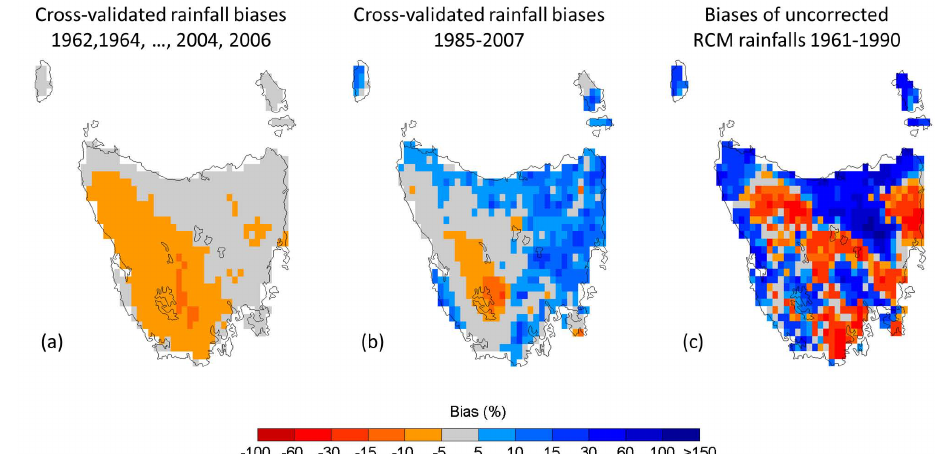
Fig. 4. Effects of changing the training period on quantile mapping performance. Plots show biases in mean annual rainfall for the 10km 2 GFDL-CM2.0 simulation. (a) Biases of bias-corrected RCM rainfall where quantile mapping is trained with the period 1962–1984; biases shown are calculated for 1985–2007. (b) Biases of bias-corrected RCM rainfall where quantile mapping is trained with odd years occurring in the period 1962–2007 (1963, 1965, ..., 2005, 2007); biases shown are calculated for even years occurring during the period 1962–2007 (1962, 1964, ..., 2004, 2006). (c) Biases of uncorrected RCM rainfalls for 1961–1990. Rainfall biases for the other five RCM simulations are very similar to the GFDL-CM2.0 simulation illustrated in this